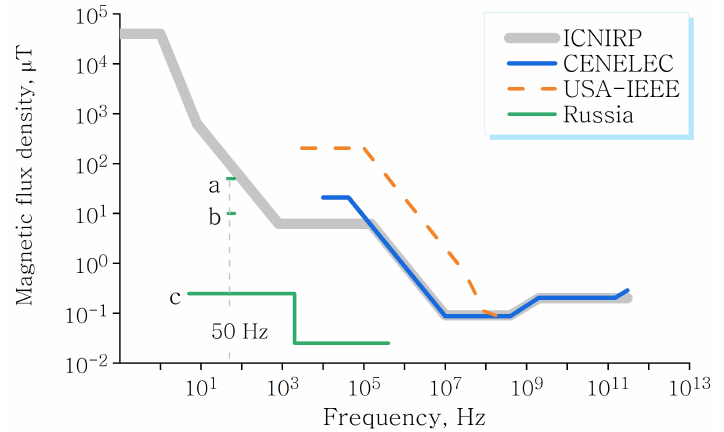
Figure 5. Maximum permissible levels of the EMF magnetic component for the population, adopted by various international organizations and in Russia. Russian standards: SanPiN 2.2.2/2.4.1340-03 and SanPiN 2.1.2.1002, ( a )—residential area, ( b )—living quarters, ( c )—temporary standard for EMF of personal